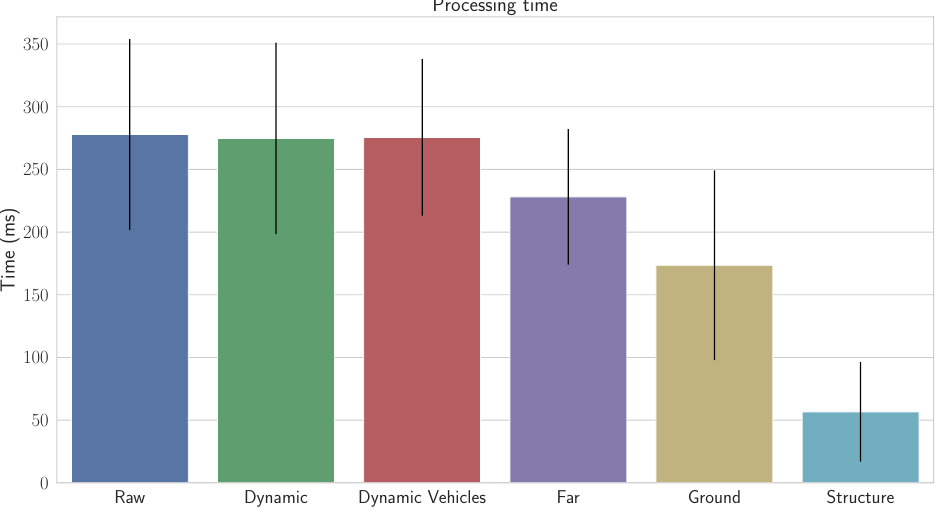
Figure 4. LOAM processing time with each of the tested input